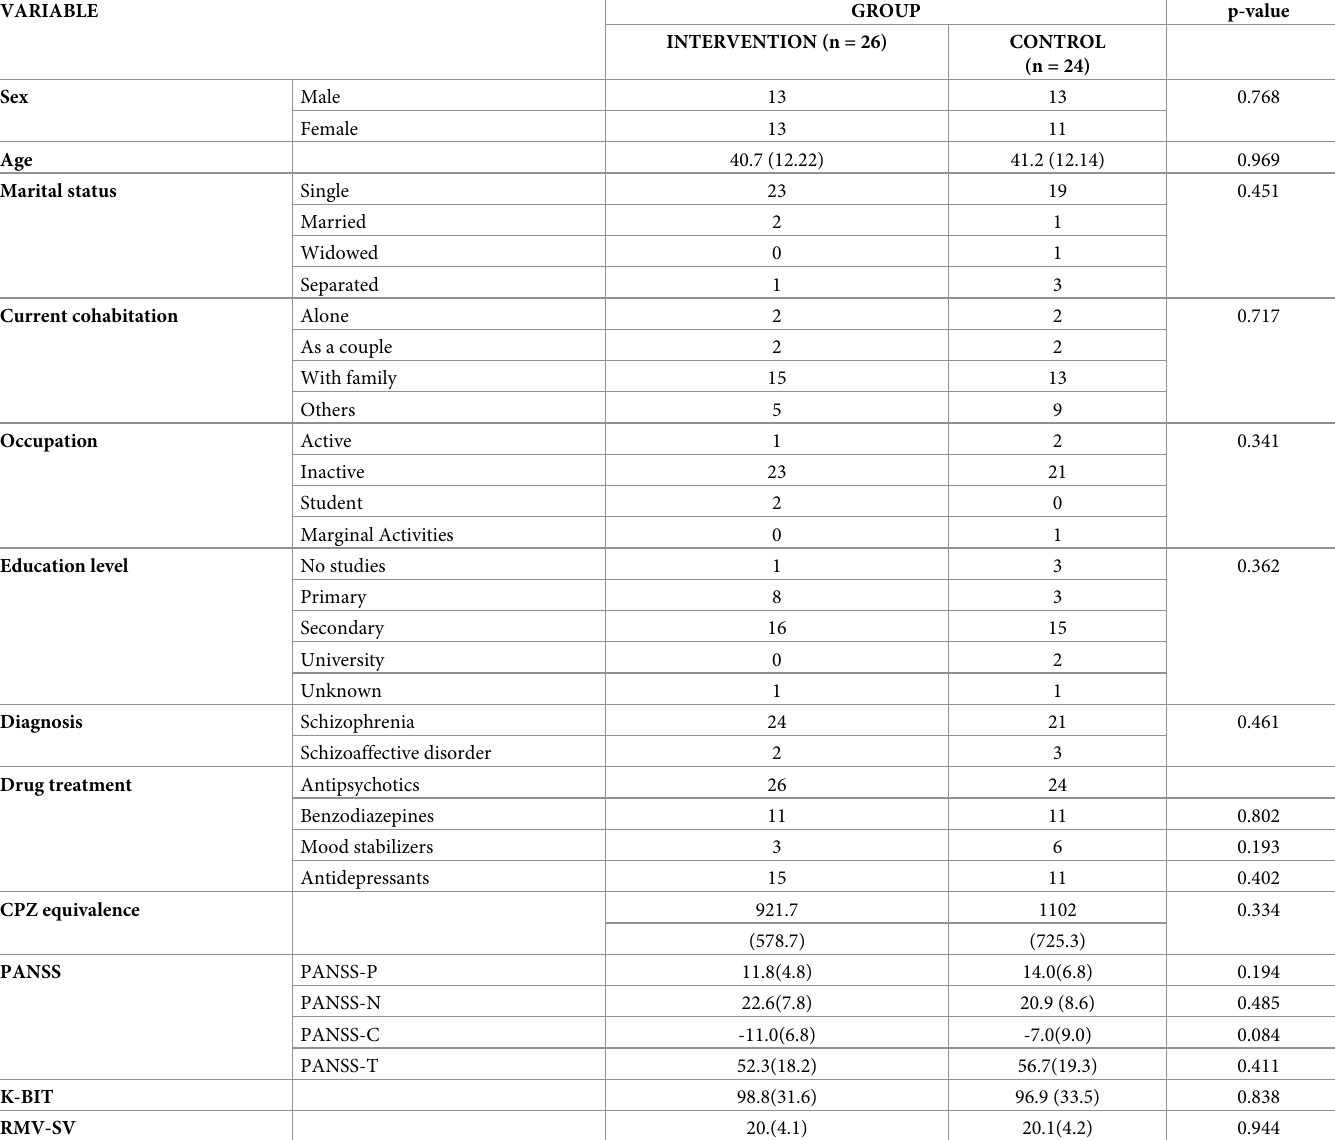
Table 5. Demographic and clinical characteristics by subgroups. means and standard deviations are presented for continuous